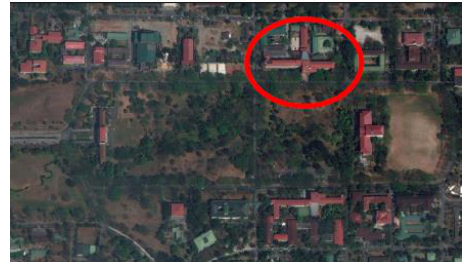
Figure 1. Location of the Melchor Hall building inside the